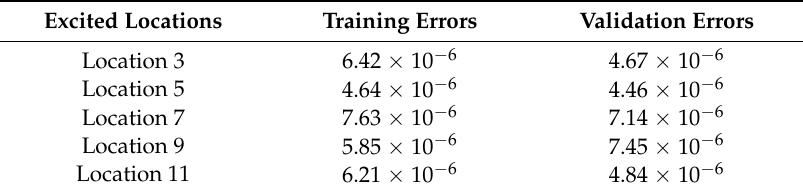
Table 11. Training errors (MSE) and validation errors (MSE) in all training load cases.